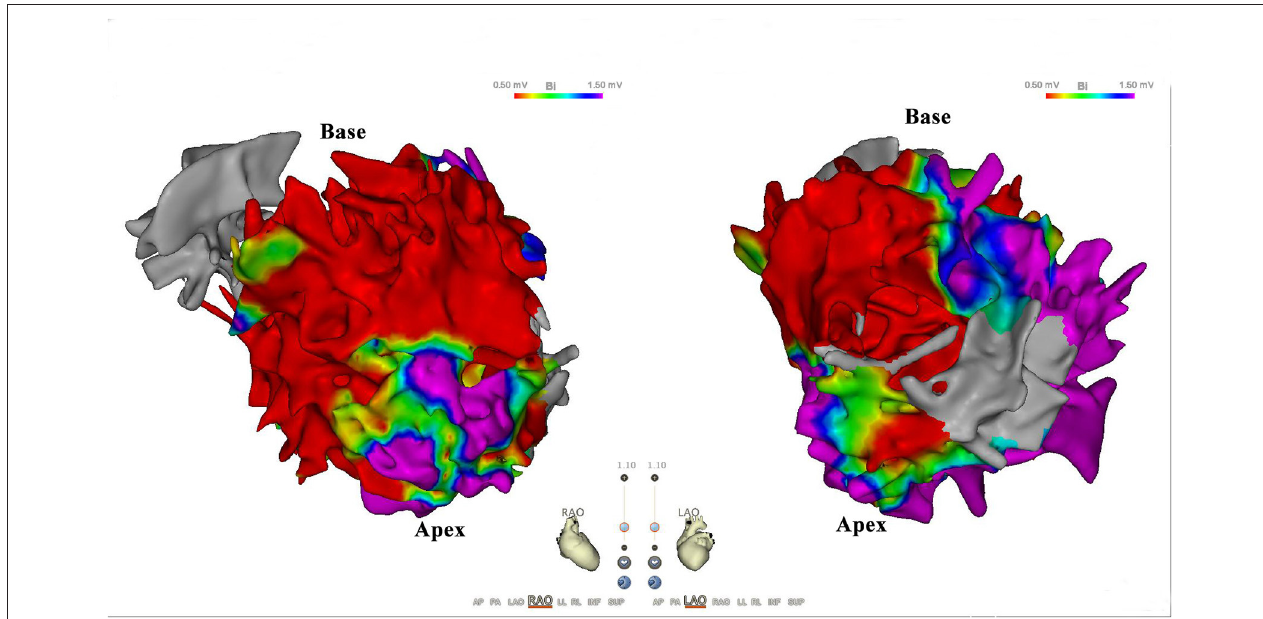
FIGURE 2 | Scar distribution in endocardium. Bipolar voltage map of the left ventricular endocardium. Scar cutoff is set at < 0.5mV (red area); border zone is set at 0.5–1.5mV. Note predilection of scar distribution to basal septal endocardium of left ventricular.